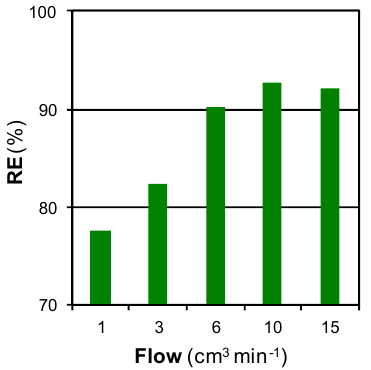
Figure 6. Effect of time on RE for regeneration at 100 bar and 250 °C with a SCCO 2 flow of 3 cm 3 ·min − 1 .